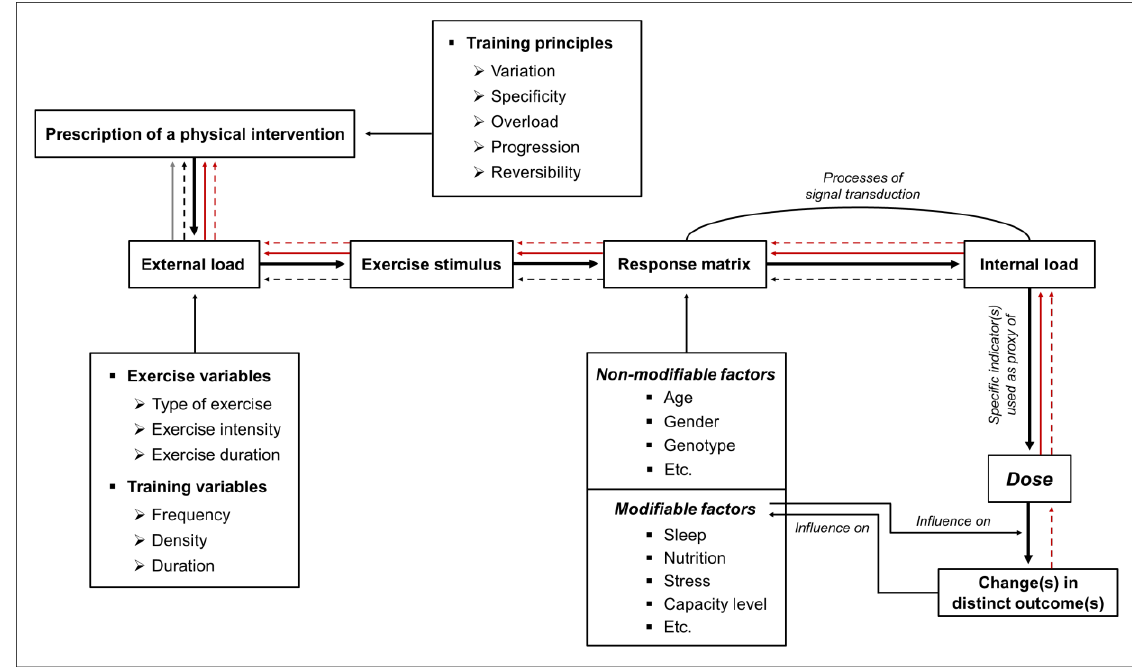
Figure 1. Schematic illustration of four approaches to prescribe physical interventions (PI). Approaches are based on (i) comparable external load (solid grey line), (ii) comparable internal load (dashed black line), (iii) comparable dose (solid red line), or (iv) comparable outcome (dashed red line). The prescription of PI is based on different exercise variables, training variables, and training principles inducing a specific exercise stimulus. In the so-called response matrix, the exercise stimulus interacts with the unique characteristics of the individual which leads to a measurable psychophysiological response (i.e., internal load). In short-term, a specific internal load can cause acute changes in distinct outcome parameters whereas the repetitive and long-term occurrence of an internal load can drive chronic changes in distinct outcome parameters (e.g., adaptations). Such chronic changes influence modifiable individual factors (i.e., capacity level) which, in turn, alter the